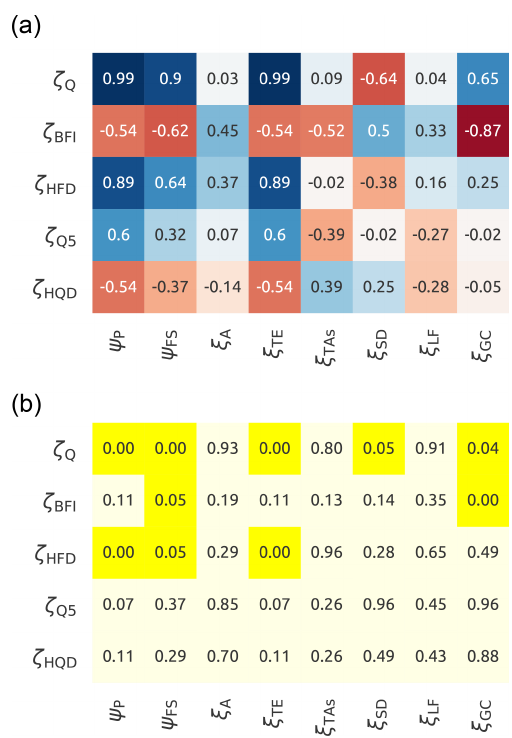
Figure 5. Correlation between the selected streamflow signatures (rows) and the selected climatic indices and catchment characteris- tics (columns). Panel (a) shows Spearman’s rank score with the red colour that indicates negative correlations and the blue that indicates positive correlations. Panel (b) reports the corresponding p values, where yellow colour indicates a statistically significant correlation ( p value < 0.05). The symbols used in the figure are reported in Ta- ble